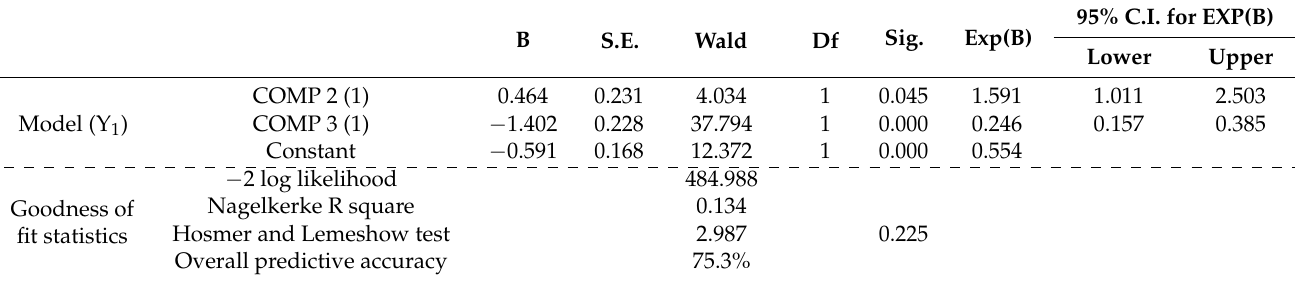
Table 8. Multivariate regression results between physical assault and explanatory